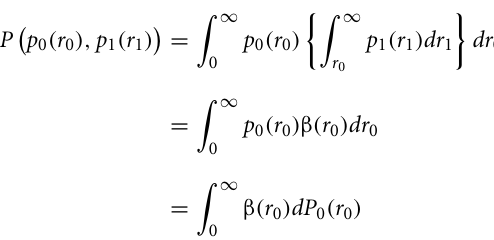
Equations (2) and (3) are also estimators of the area under